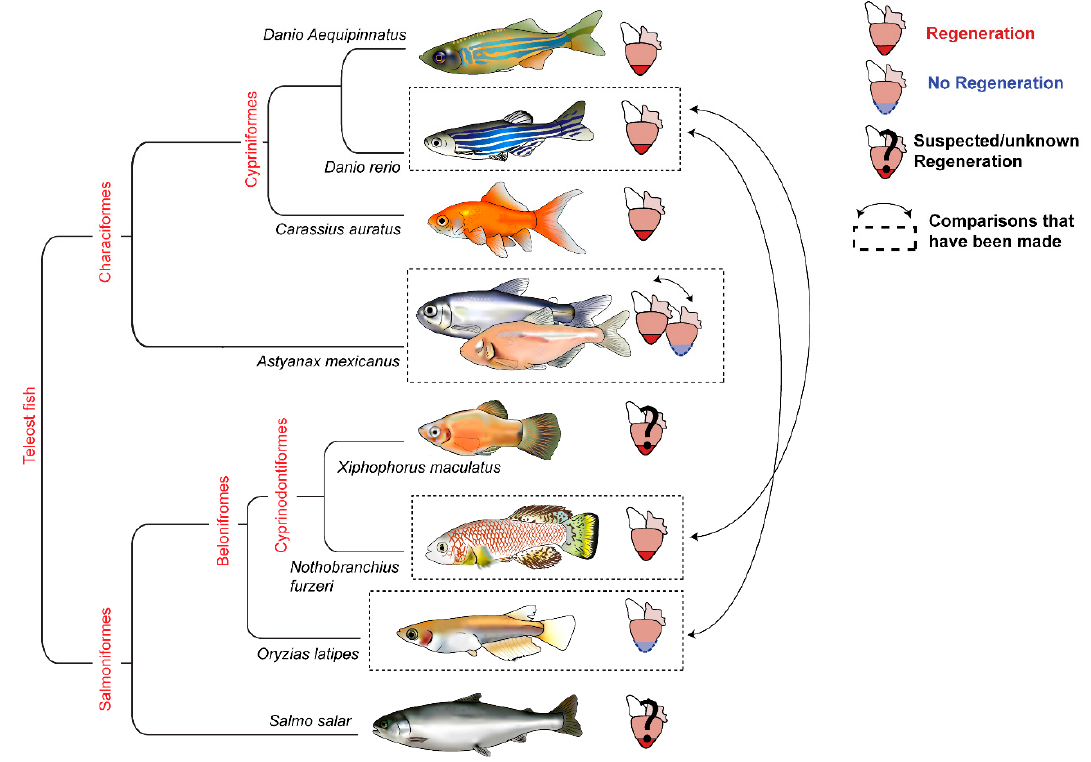
Figure 3. Phylogenetic tree of teleost fish models of regeneration.